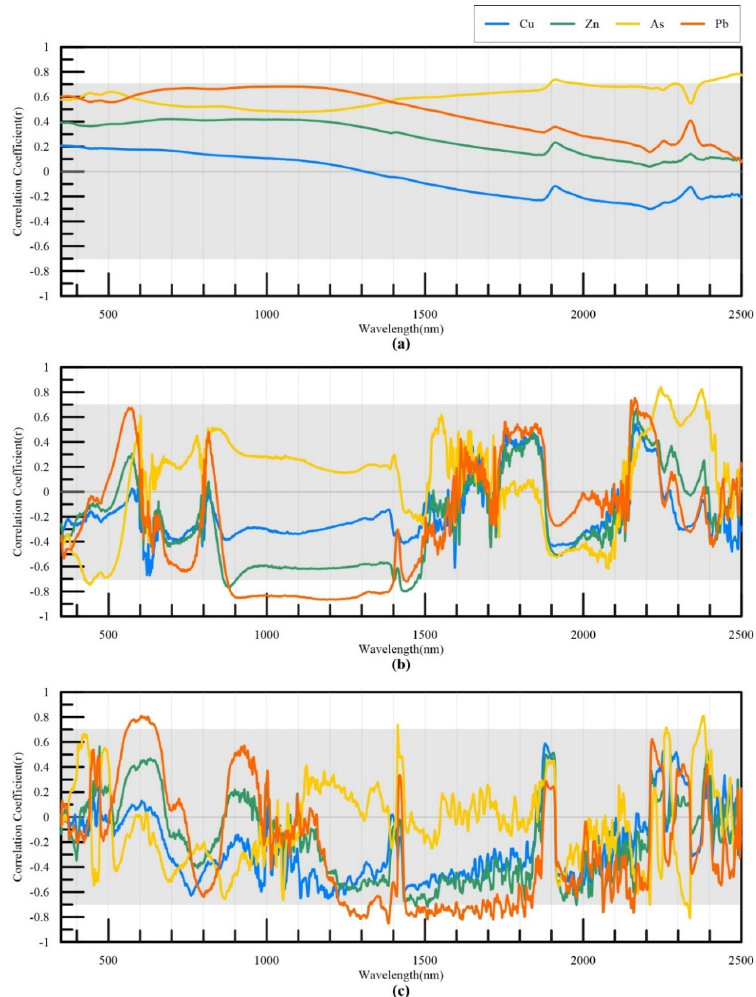
Figure 7. Correlograms between Heavy metal concentration and ( a ) reflectance, ( b ) absorption depth, and ( c ) first derivative of Group B.